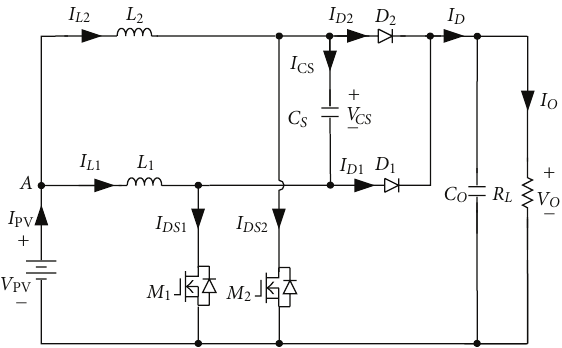
Figure 4: Topology of the proposed interleaving boost converter with a single-capacitor turn-o ff snubber for battery charger applications.